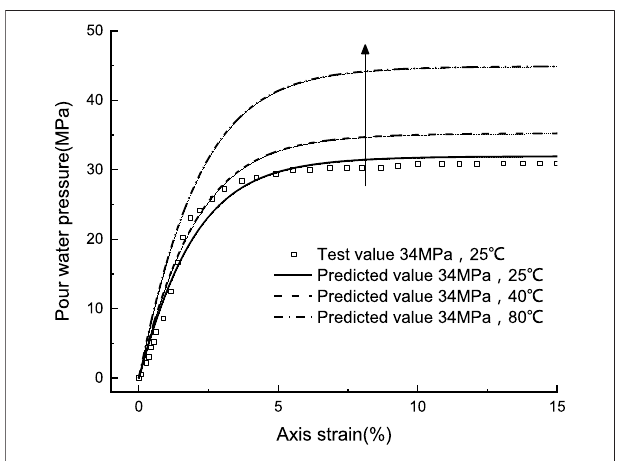
FIGURE 5 | Stress-strain relationship and model prediction results of dense sandy soil under different temperatures.